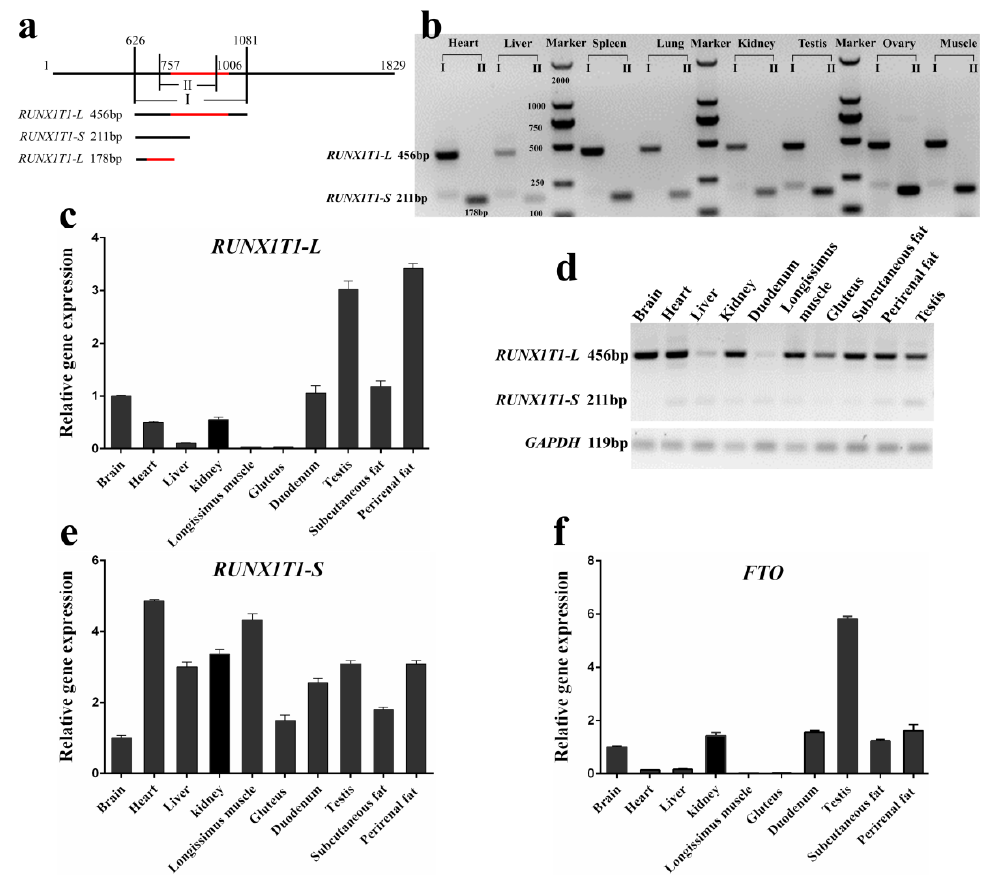
Figure 4. Expression pattern of RUNX1T1 isoforms in different tissues from 6-month-old Hu sheep. ( a ) Primer I was designed for identifying RUNX1T1 isoforms, primer II was used for qPCR of RUNX1T1-L mRNA. The red line represents the region which is present in the long isoform and absent in the short isoform. Depending on isoforms, bands of either 456 bp or 211 bp can be detected ( b ). Real-time PCR of mRNA for RUNX1T1-L (178 bp; ( c )) and FTO ( f ) in different tissues. Expression of the RUNX1T1-S (211 bp) in different tissues were determined by semi-qRT-PCR ( d , e ). Expression of gene was normalized to that of glyceraldehyde-3-phosphate dehydrogenase ( GAPDH ), and relative to the expression in brain. Quantitative data are represented as the mean ± SEM ( n =